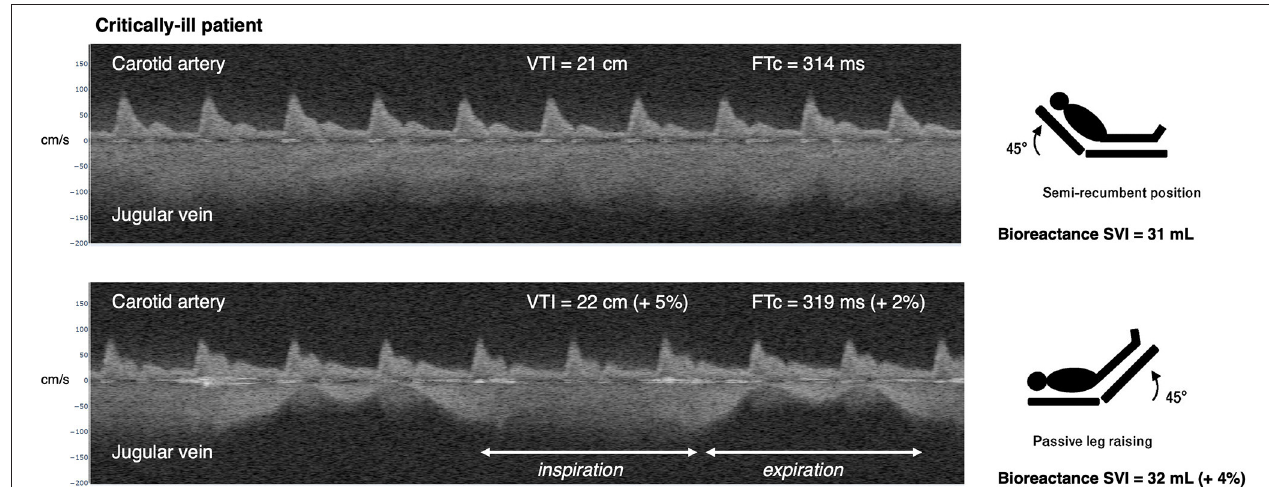
FIGURE 4 | Example of simultaneous carotid arterial and jugular venous Doppler in a patient with septic shock during passive leg raise. At baseline, in semirecumbent, the patient has continuous (low P ra ) jugular venous Doppler morphology. Upon PLR, the venous morphology transitions to a pulsatile waveform on expiration. On inspiration, the velocity is high, suggesting inspiratory collapse of the jugular vein. There is no augmentation of carotid arterial Doppler metrics during PLR. Compare this response to the “abnormal” P ra -SV relationship in Figure 1 . VTI is velocity time integral in centimeters, cm. FTc is corrected flow time in milliseconds, ms. SVI is stroke volume index in milliliters, ml. cm/s is centimeters per